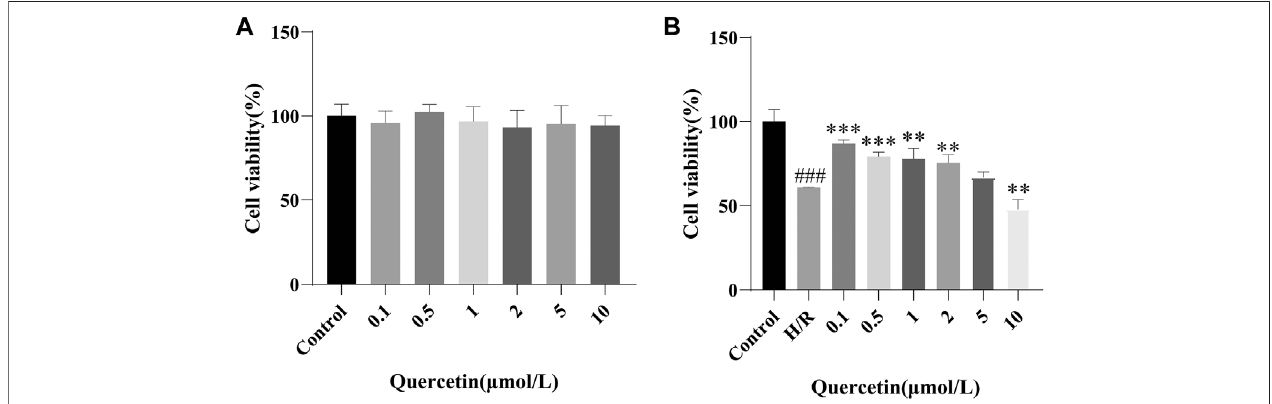
FIGURE 1 | (A) HBMECs were treated with quercetin (0, 0.1, 0.5, 1, 2, 5, 10 μ mol/L) for 24 h, viability was measured using CCK-8 method (B) HBMECs were treated with quercetin (0, 0.1, 0.5, 1, 2, 5, 10 μ mol/L) and H/R treatment, viability was measured using CCK-8 method. ### p < 0.001 compared to control group; ** p < 0.01, *** p < 0.001 compared to H/R group. H/R: hypoxia and reoxygenation, n (cid:2)